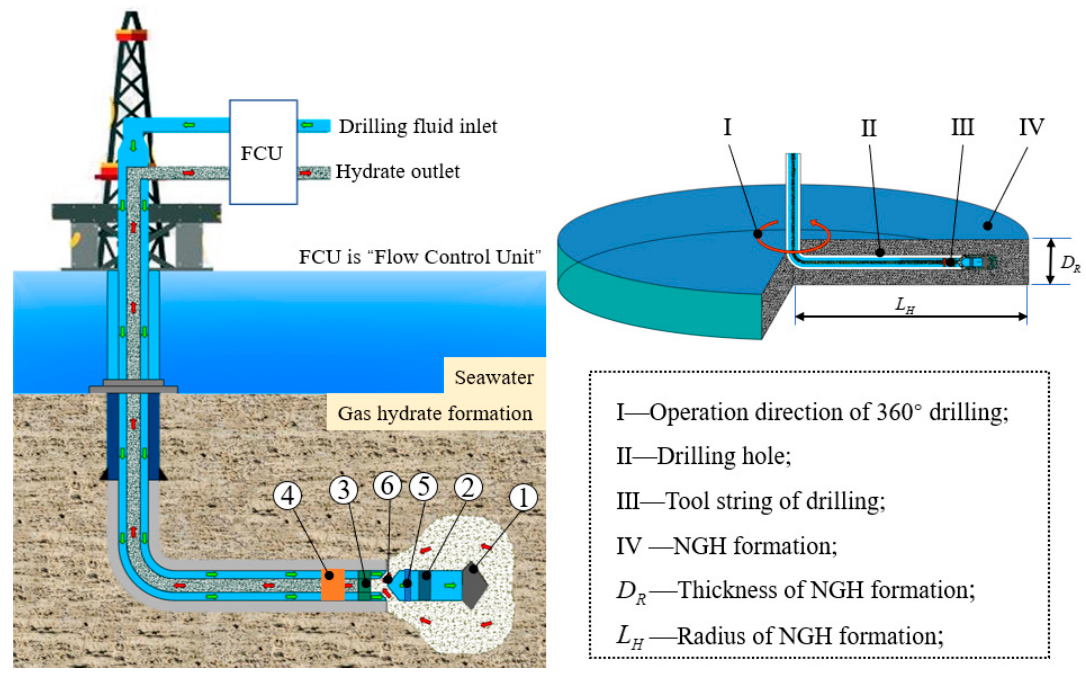
Figure 1. DDG method. Figure 1. DDG Table 1. Main tools and functions of drilling and production tool string.